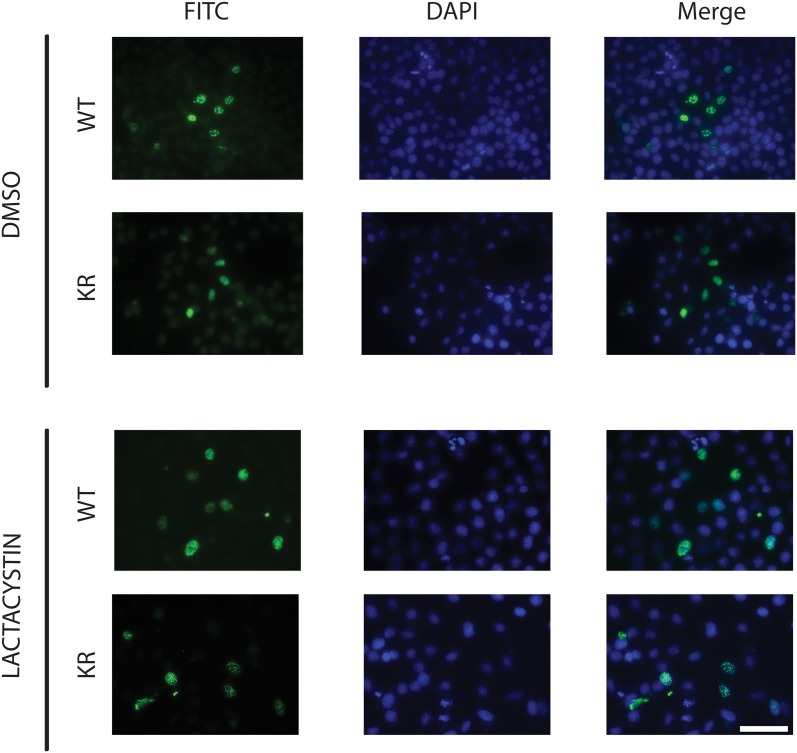
Localization of MAML1 in HeLa cells.MAML1 was mutated at various lysine residues as described in text. Myc-tagged MAML1 Wild type (WT) or Mutant (KR) was expressed in HeLa cells. Twenty-four hours post-transfection, cells were either treated with DMSO or lactacystin (10 μM) and left for an additional 24 hours. Cells were then fixed in 4% paraformaldehyde and processed for immunocytochemistry. Both MAML1 and MAML1 KR mutant localize to nuclei in discrete foci. Images show MAML1 WT and KR with FITC stain alone, DAPI stain to detect nucleus along, or merged to show overlap. Scale Bar is 50 μm.